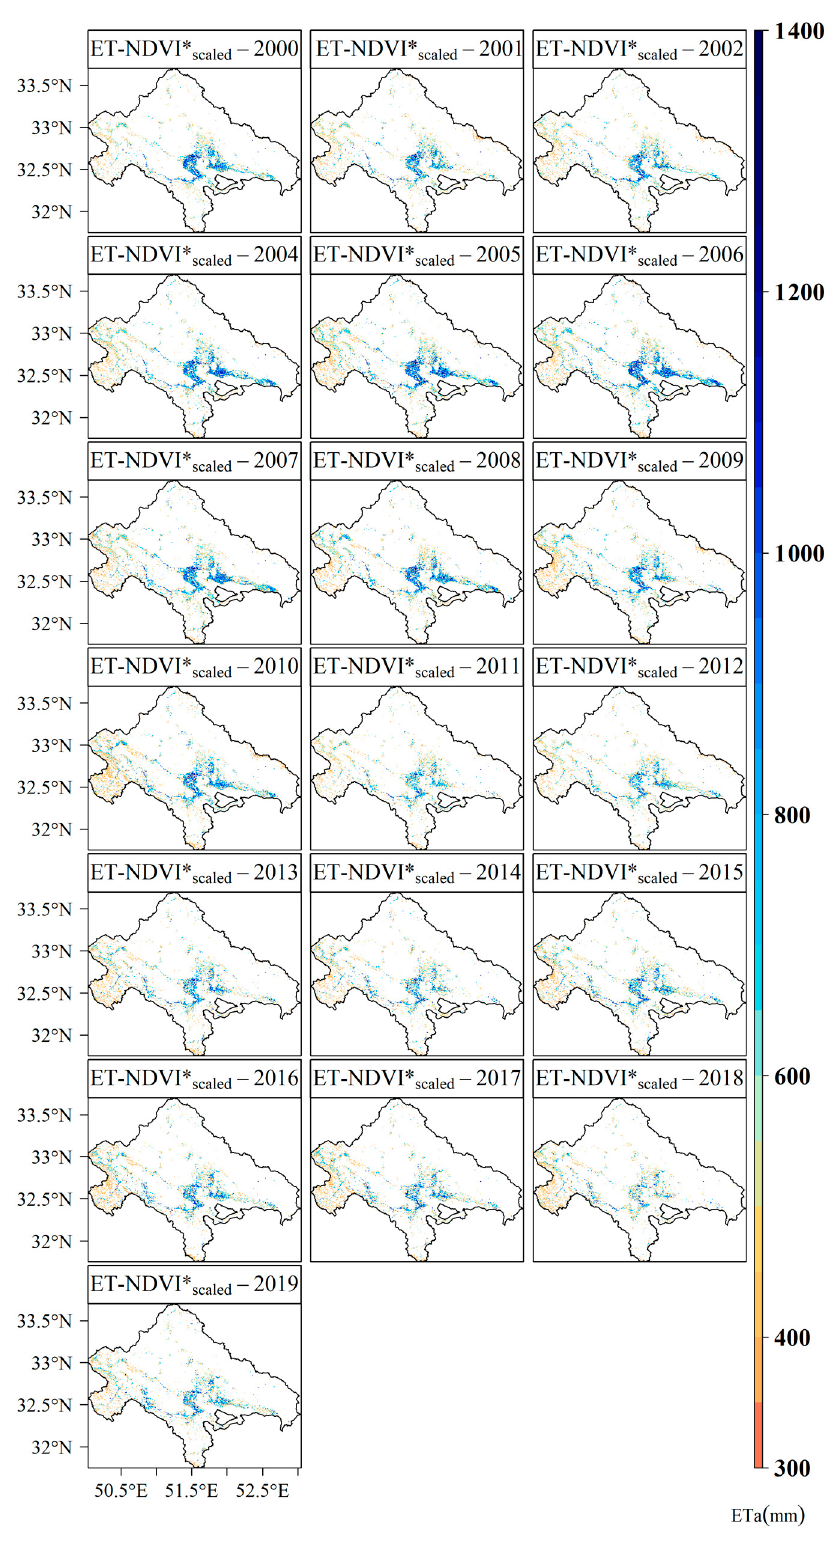
Figure A3. Annual maps of ET-NDVI* scaled .